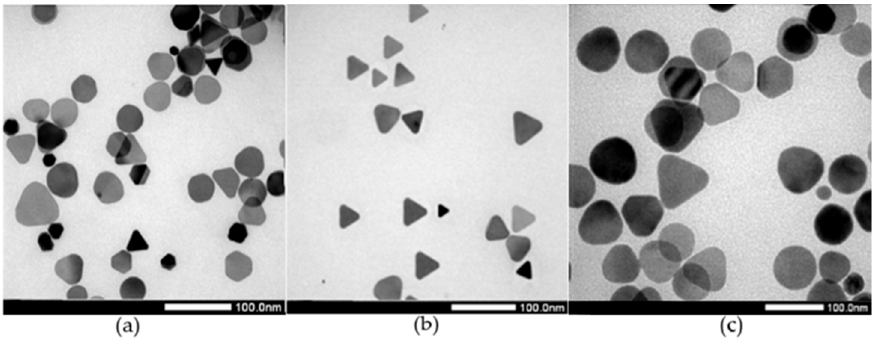
Figure 6. TEM images of silver nanoparticles synthesized mixed gelatin (0.2%, w/v)-chitosan (0.06%, w/v) solution at ( a ) pH 4.0, ( b ) pH 6.0, and ( c ) pH 8.0 (scale 100 nm).